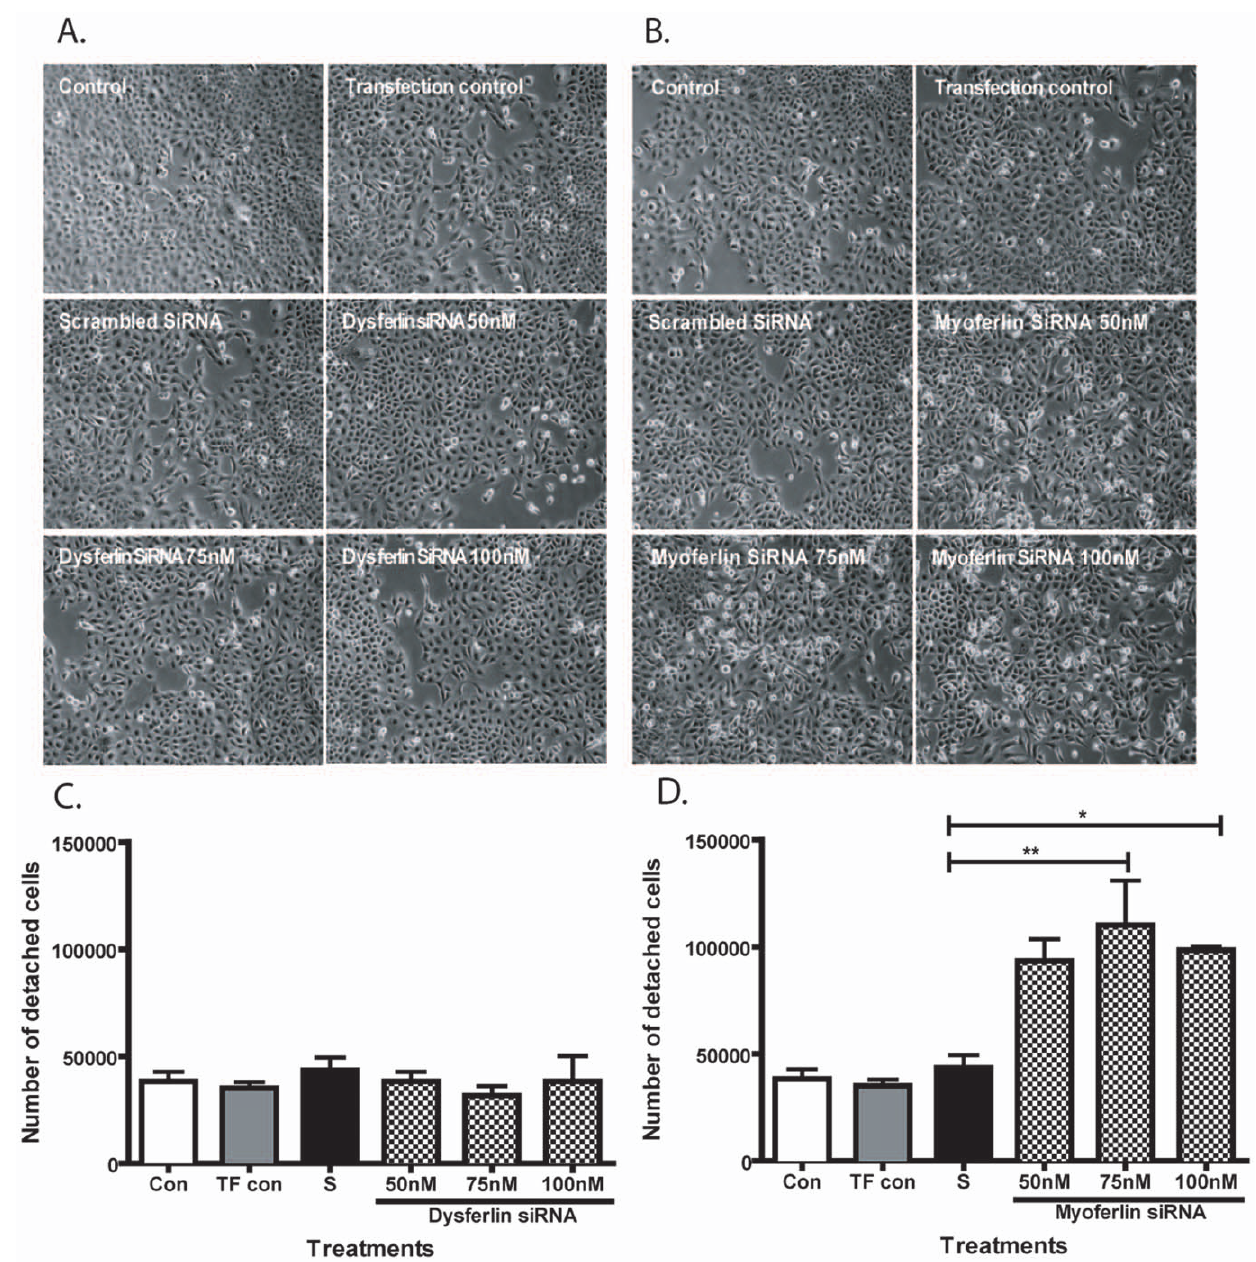
Figure 5. Knockdown of myoferlin but not dysferlin alters cell morphology and cell detachment. Phase contrast images captured at 10 6 magnification of 16HBE cells treated with control media, transfection control, scrambled siRNA, and (A) dysferlin siRNA or (B) myoferlin siRNA at 50 nM, 75 nM and 100 nM for 72 h. Detached cells within cell culture supernatants were counted in each treatment group following (C) dysferlin or (D) myoferlin siRNA treatment using a hemocytometer. Data are presented as mean 6 SEM of three independent experiments. A significant difference between the treatment groups and scrambled siRNA control is indicated by asterisk (* p , 0.05; ** p , 0.01). doi:10.1371/journal.pone.0040478.g005 cadherin, as well as tight junction molecules occuldin, claudin-1, transfection control conditions (Figure 7B and C). We and ZO-1 and extracellular matrix (ECM) adhesion receptor integrin others have previously shown that loss of cell-cell contacts and b 1 during knockdown of dysferlin and myoferlin. Dysferlin acquisition of a spindle shape morphology are two of the initial knockdown did not result in cell detachment; and as expected, morphological changes associated with epithelial-mesenchymal we did not detect any difference in the expression of any of the transition (EMT). To confirm that loss of ZO-1 was not adhesion proteins measured (Figure 7A). In comparison, associated with EMT we analyzed the expression of E-cadherin myoferlin knockdown led to a decrease in the expression of and mesenchymal marker fibronectin-EDA by immuno blot. As ZO-1 at all myoferlin siRNA concentrations, but not E-cadherin, shown by the densitometry analysis in figure S2 we observed no occludin, claudin-1 or integrin b 1 when compared to the differences in the expression of E-cadherin or fibronectin-EDA.